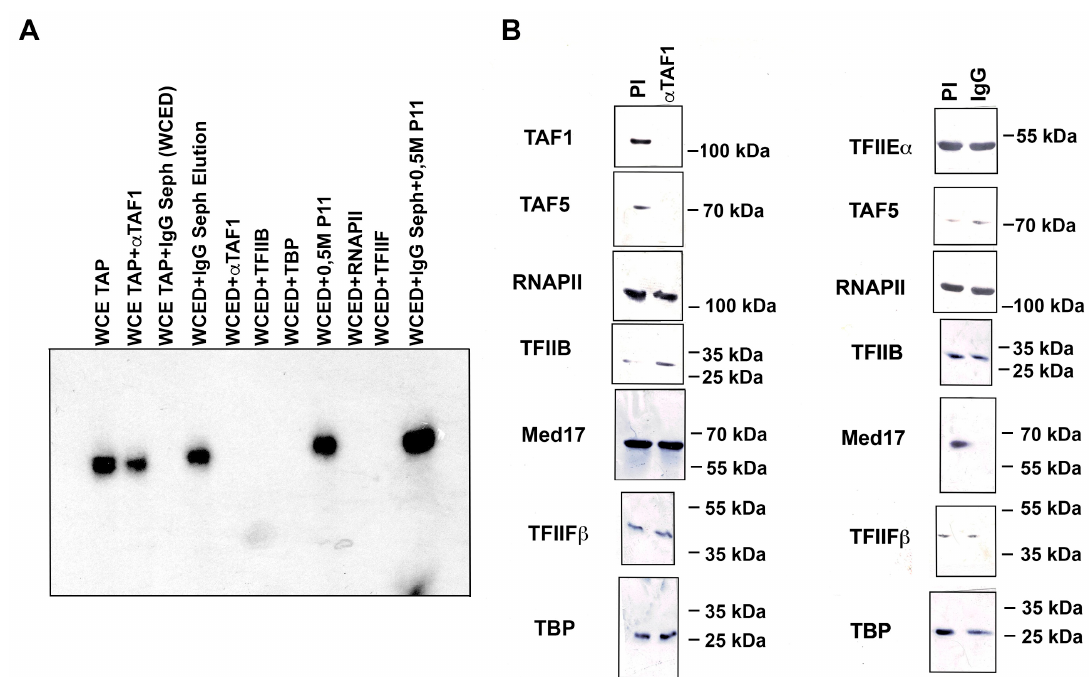
Figure 4. Mediator depletion inhibits nmt1 Inr transcription. ( A ) Mediator was depleted from a WCE from a TAP-tagged Med7 strain using IgG-Sepharose beads, and transcription was recovered by replacing different combinations of factors. The WCE from the same TAP-tagged strain was depleted of TAFs using anti-TAF1 antibodies crosslinked to Sepharose beads. It is observed that Mediator depletion completely abolishes transcription of the nmt1 Inr (WCED), and is recovered by replacing an eluate from the IgG-Sepharose beads (WCED + IgG Seph. Elution), with a crude fraction from a P11 chromatographic fraction of WCE (WCED + 0.5 M P11), or with the same fraction plus the elution of the IgG-Sepharose column (WCED + IgG Seph + 0.5 M P11). TFIIB, TBP, RNAPII, or TFIIF cannot complement for the activity eluted from the IgG-Sepharose beads. Importantly, TAF-depletion has no effect on nmt1 Inr transcription (WCE TAP + α TAF1) and an eluate from the anti-TAF1 beads cannot complement Mediator depletion (WCED + TAF1). ( B ) Western blot analysis with different antibodies was used to test the extension of the depletion of the WCED. It is observed that Mediator was completely depleted (Med17 panel) by IgG Sepharose beads, and TAFs are depleted by anti-TAF1 Sepharose beads (TAF5 panel). Depletion of Mediator does not affect the levels of TAFs, and depletion of TAFs does not affect Mediator levels. Levels of RNAPII and other transcription factors are not affected by either Mediator- or TAF-depletion.